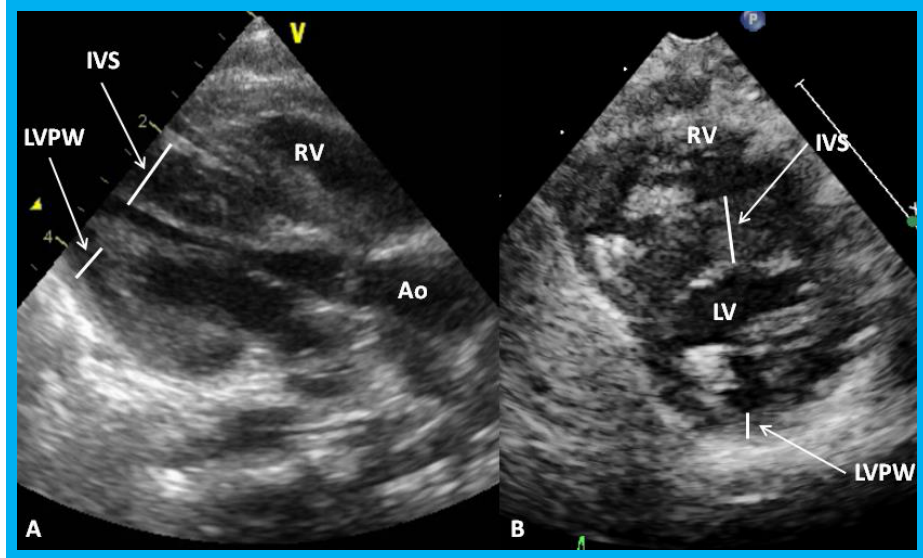
Figure 25. Parasternal long ( A ) and short ( B ) axis views of the left ventricle (LV) demonstrating markedly thickened interventricular septum (IVS) in an infant of a diabetic mother. Ao, aorta; LVPW, LV posterior wall thickness; RV, right ventricle.